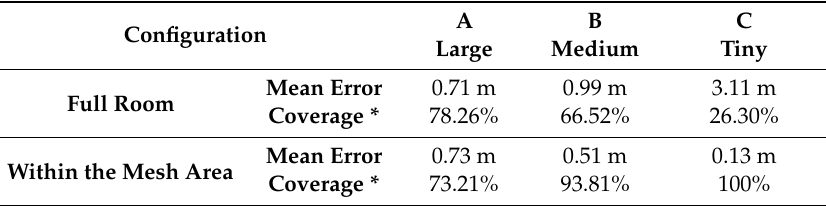
Table 2. Simulated positioning error results.